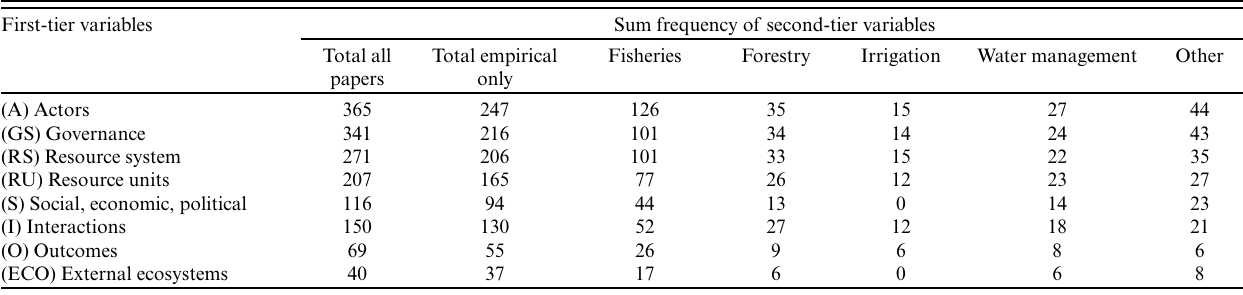
Table 4. First-tier variable frequency of all articles. “All” shows the sum of second-tier variables at the first tier from Fig. 2. “All” includes all types of articles. The sum total of “All” is then subdivided by those articles that have an empirical focus in major sectors. The total number of articles with an empirical focus is shown, followed by the sum of empirical totals in each of the most relevant